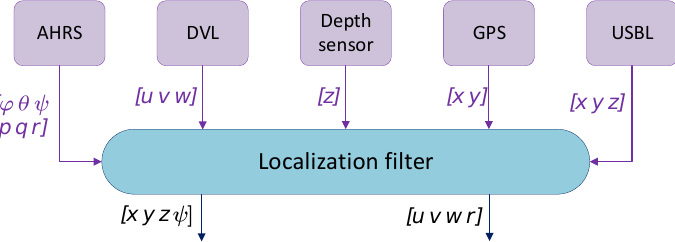
Figure 1. Implemented filter in the localization and mapping system for the Girona500